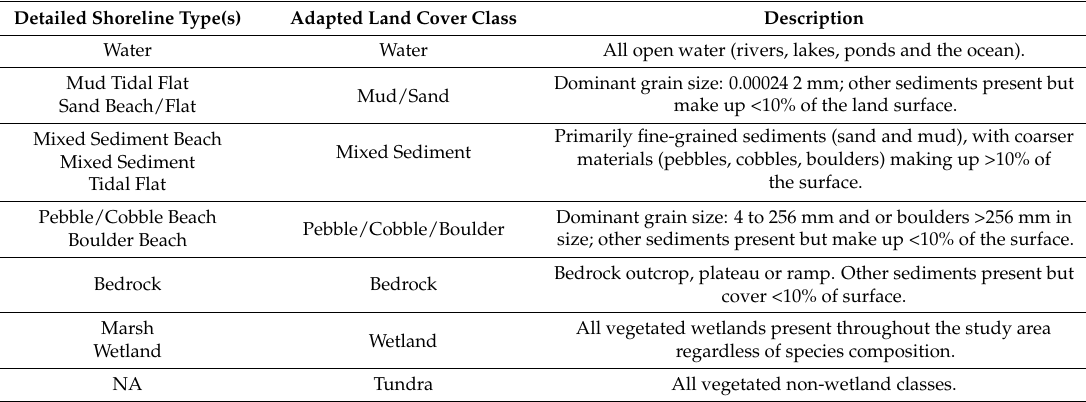
Table 2. Shoreline types and generalized land cover classes in the study area. This figure is adapted from